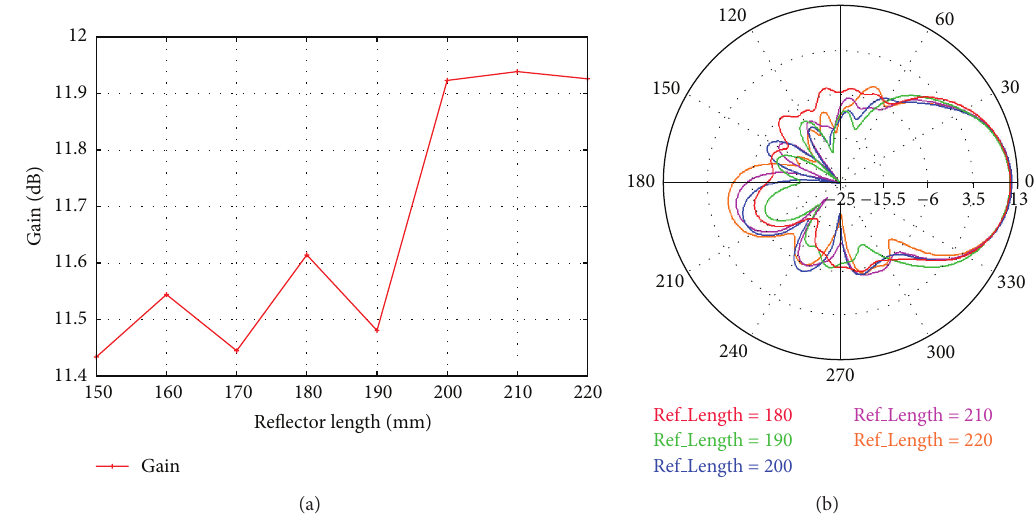
Figure 17: Simulated gain patterns computed using CST: (a) realized gain values, (b) 2D gain patterns.